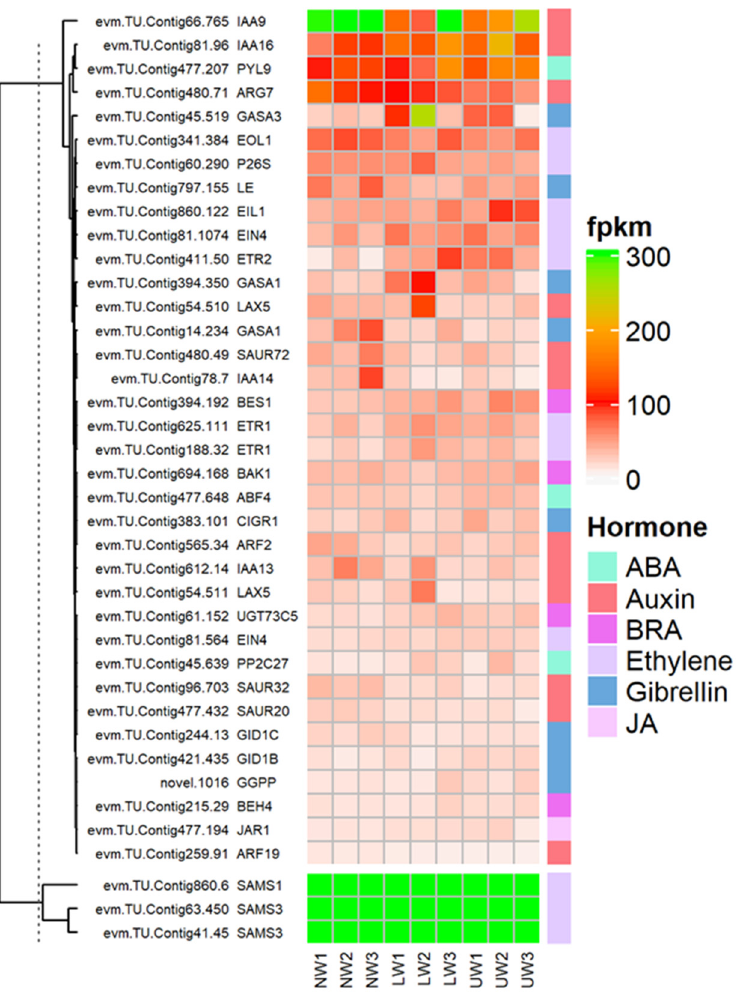
Figure 5. Differential expression of genes and TFs associated with hormonal signaling and synthesis- related genes in the studied